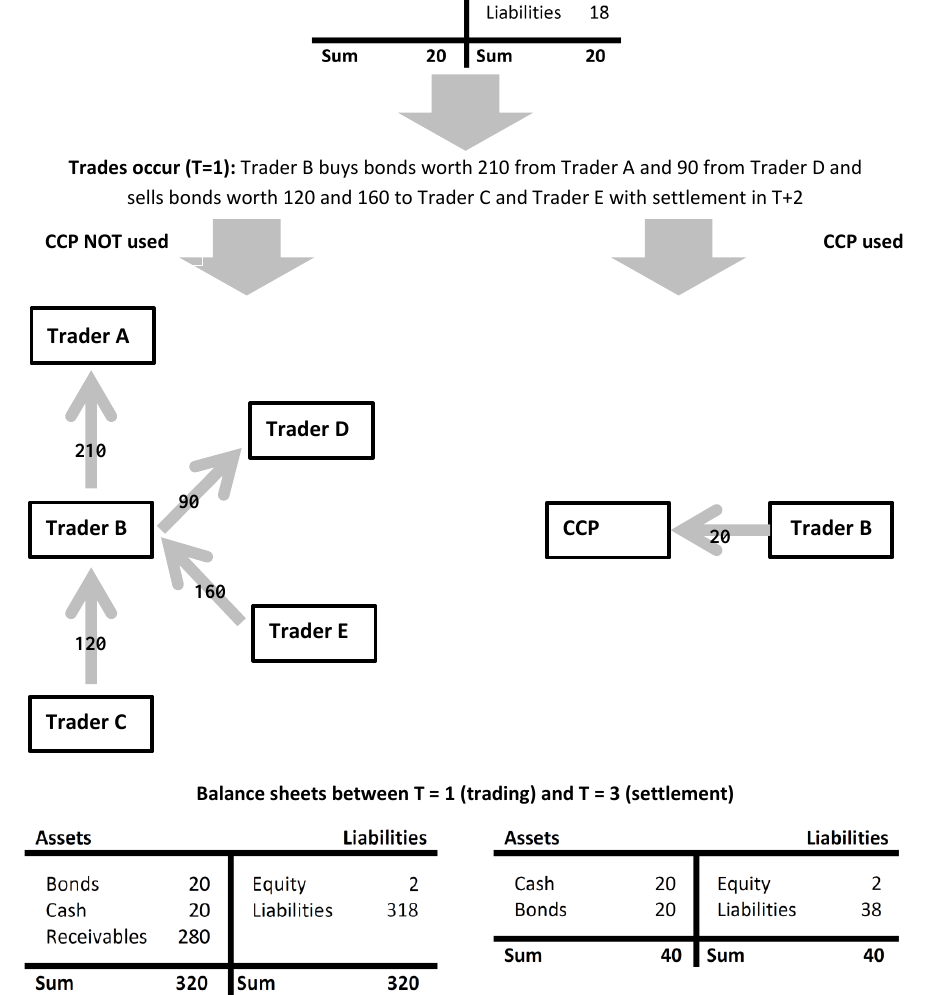
Figure 5. Example of dealer balance sheet. This figure shows the development of the balance sheet of a trader between settlement and trade date depending on whether CCP services are used or not. The top shows exemplary initial balance sheets of the fictitious dealer B. It is assumed that this dealer buys bonds worth 210 from Trader A and 90 from Trader D and sells bonds worth 120 (160) to dealer C (E) at time T = 1. The left-hand side of the figure shows the bilateral trading relationships as well as the balance sheet between trade and settlement date (T = 3) without the use of a CCP, while the right-hand side shows the case with the involvement of a CCP (all dealers are members of the CCP, and transactions can be